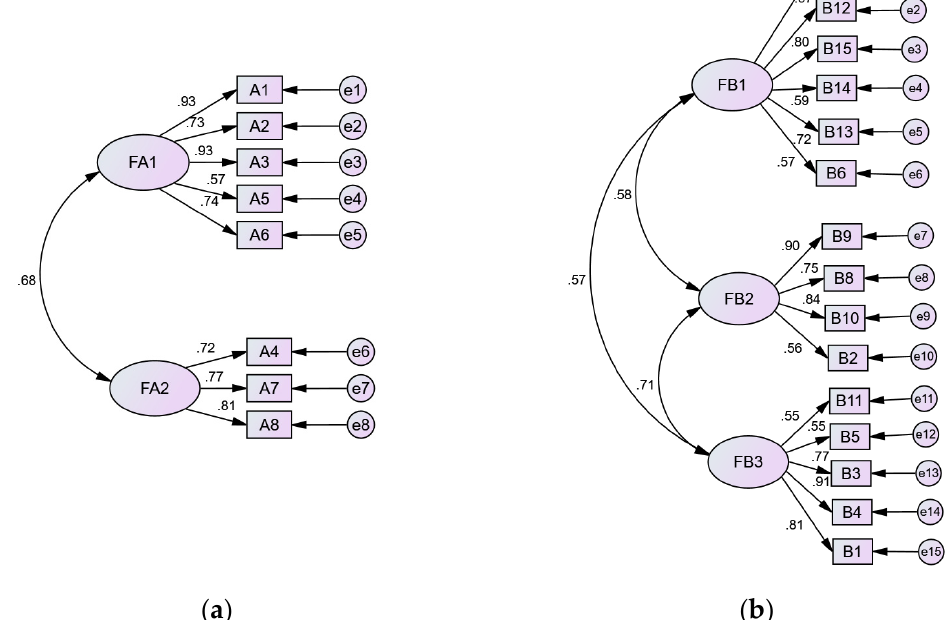
Figure A1. The graphs of the data structure models yielded by the CFA of the two aspects of system usability and user interaction satisfaction. ( a ) The graph of the structure model of the aspect of system usability (FA1: ease to learn; FA2: applicability). ( b ) The graph of the structure model of the aspect of user interaction satisfaction (FB1: goodness to life; FB2: ease to learn; FB3: feeling of use). Table A9. The fit indices of the data structure models of the two indicators of system usability and user interaction satisfaction computed by CFA a .